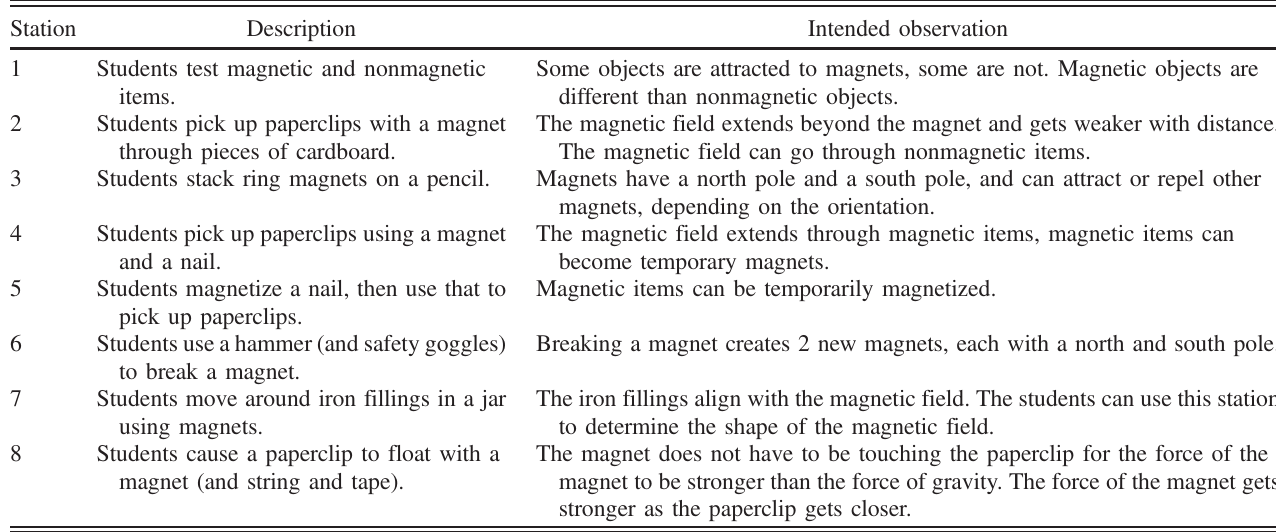
TABLE II. List of magnetism stations for data collection and the intended student observations at each